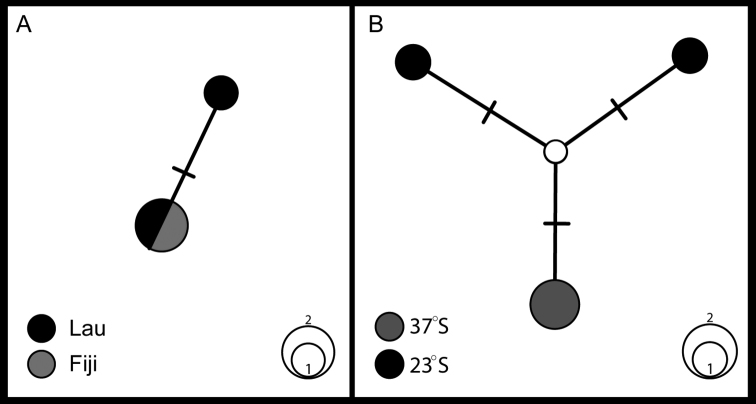
Haplotype networks from COI data: AThermiphionefijiensis network includes two sequences from specimens from the Lau Back-Arc Basin (black), and one from the type locality in Fiji (grey) BThermiphionerapanui sp. n. network includes two sequences from 23°S (black) and two from 37°S (grey).